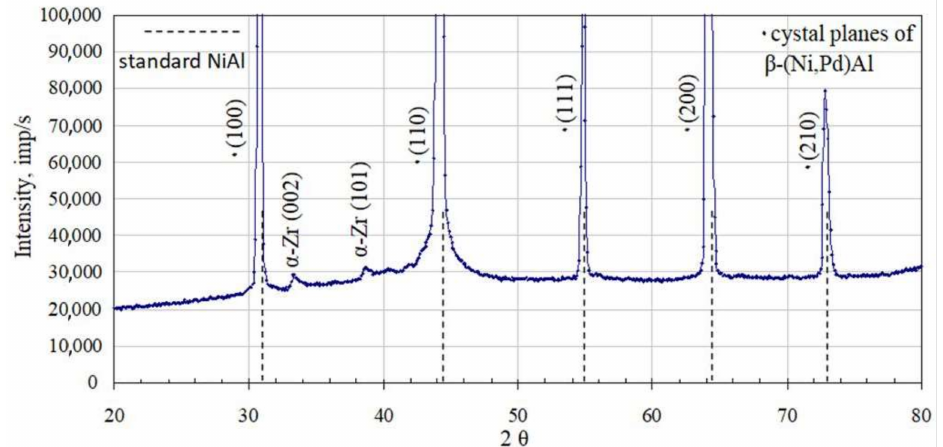
Figure 6. XRD diffraction pattern of the palladium and zirconium co-doped aluminide coating deposited on CMSX 4 superalloy.